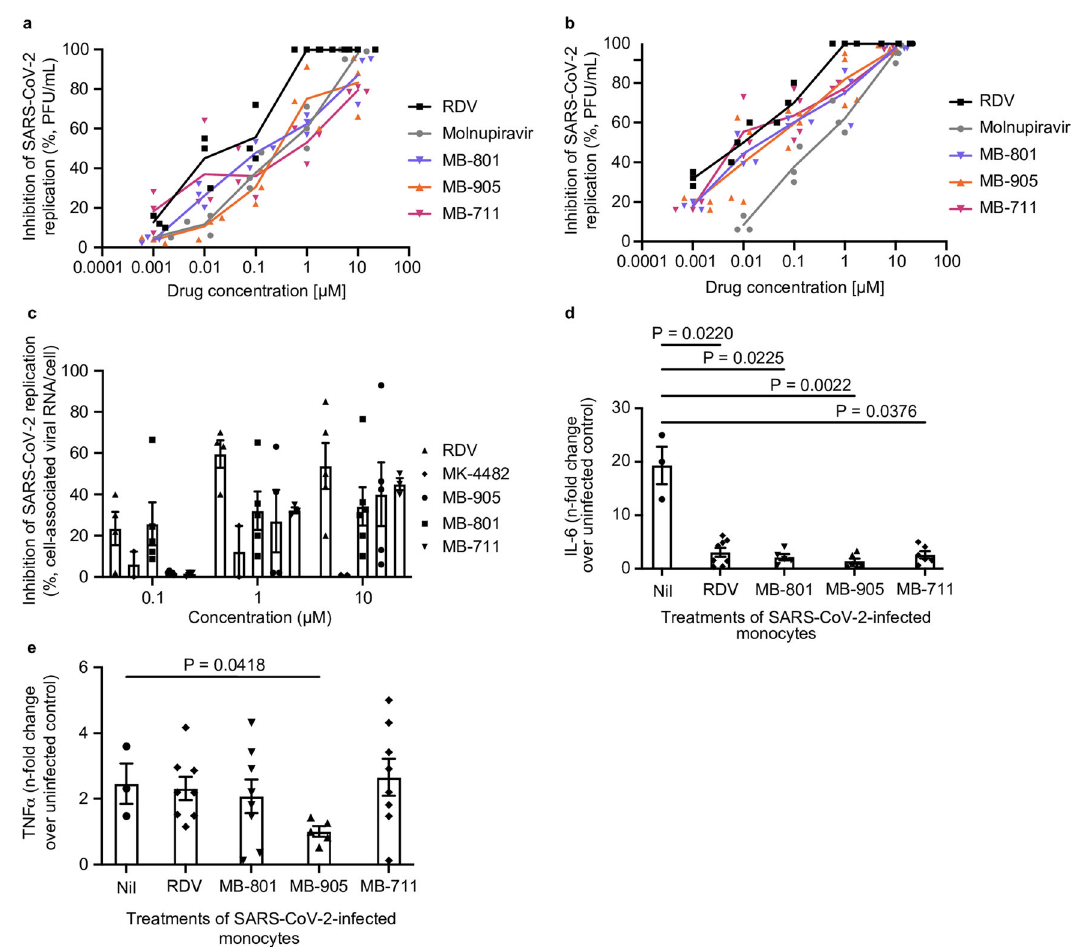
Fig. 1 | The antiviral and anti-in fl ammatory activities of the MBs against SARS- CoV-2. Calu-3 cells at a density of 5×10 4 cells/well in 96-well plates were infected with SARS-CoV-2 at an MOI of 0.1 for 1h at 37°C. The inoculum was removed, the cells were washed and incubated with fresh DMEM containing 2% fetal bovine serum (FBS), and the indicated concentrations of the compounds were added immediately thereafter ( n =3) ( a ), or the cells were also treated an additional time at 24h postinfection ( n =3) ( b ). After 48h, cell supernatants were harvested, and infectious viral titers in the culturesupernatant were measured by PFU/mL in Vero cells. Human primary monocytes were infected at an MOI of 0.1 and treated with